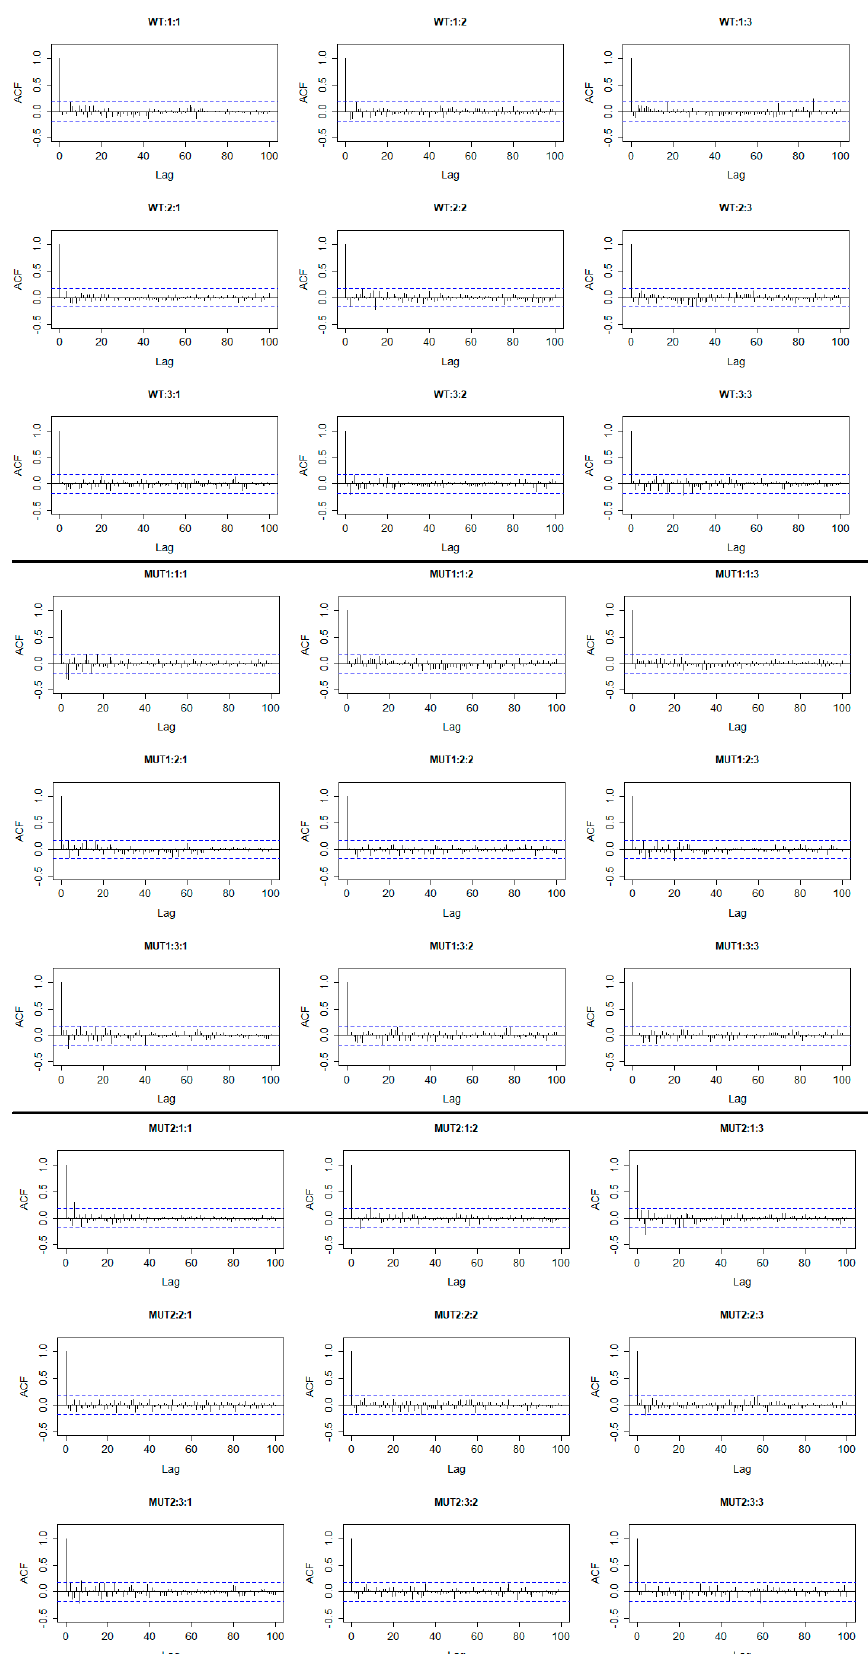
Figure 4. Estimated autocorrelations of the final residuals 𝑟 (cid:3036)(cid:3037) . The title of each plot refers to Genotype: Replicate: Experiment. The dashed blue lines represent the 95% confidence interval. (WT: Wild